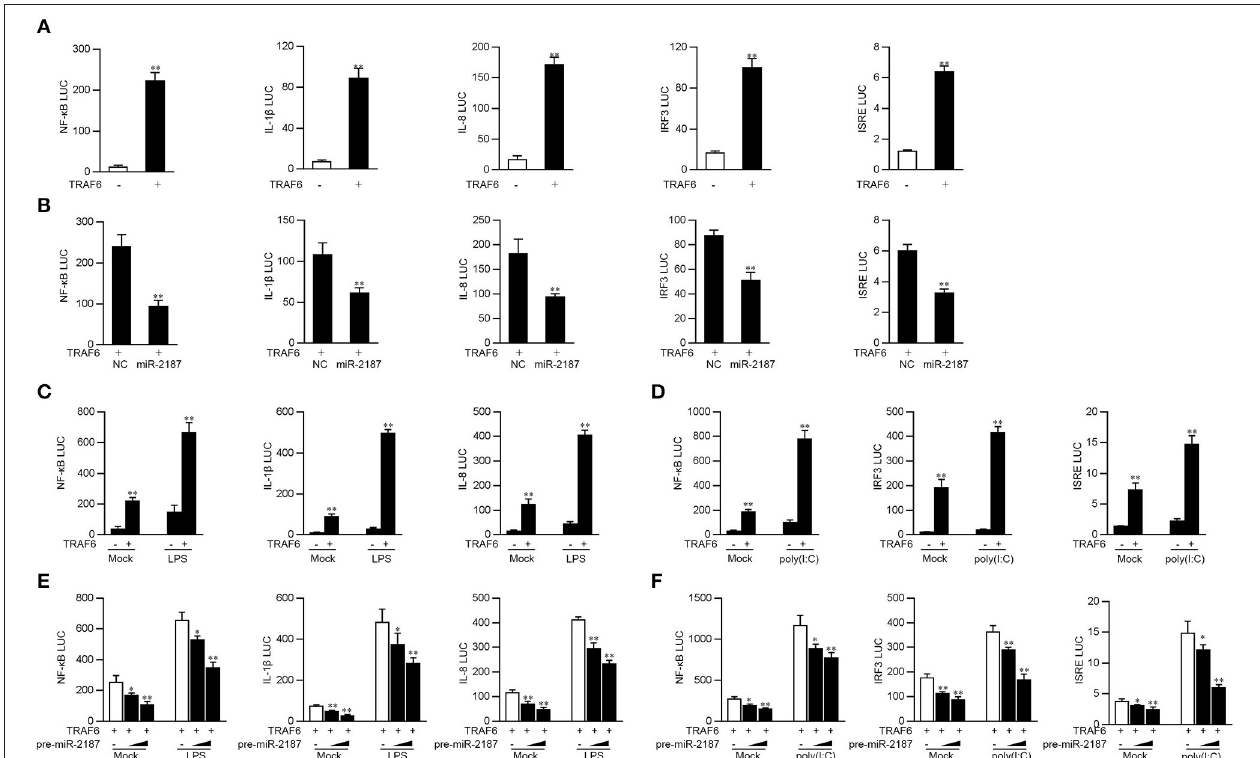
FIGURE 5 | Overexpressed miR-2187 depresses TRAF6-mediated NF- κ B and IRF3 signaling. (A) Co-transfect EPC cells with TRAF6 expression plasmid, phRL-TK Renilla luciferase plasmid and NF- κ B, IL-1 β , IL-8, IRF3, or ISRE luciferase reporter gene for 24h, and then measure luciferase activity. (B) Luciferase test showed that co-transfection of TRAF6 expression plasmid and NC or miR-2187 with EPC reduced luciferase activity. Co-transfect EPC cells with TRAF6 expression plasmid and stimulated with LPS (1 mg/ml) (C) for another 6h or poly(I:C) (1 mg/ml) for 12h (D) . (E) EPC cells were transfected with miR-2187 in a concentration gradient manner, together with luciferase reporter gene for 24h and stimulated with LPS (1 mg/ml) for another 6h or poly(I:C) (1 mg/ml) for 12h (F) . Afterward, the luciferase activity was measured. All the luciferase activity was normalized to Renilla luciferase activity. All data are presented as the means ± SE from three independent triplicated experiments. ** p < 0.01; * p < 0.05 vs. the